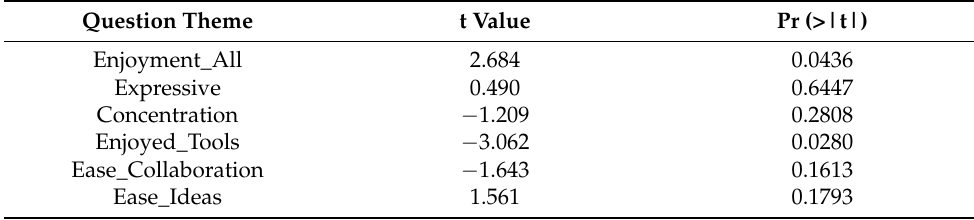
Table 6. Correlates of confidence level in co-design with